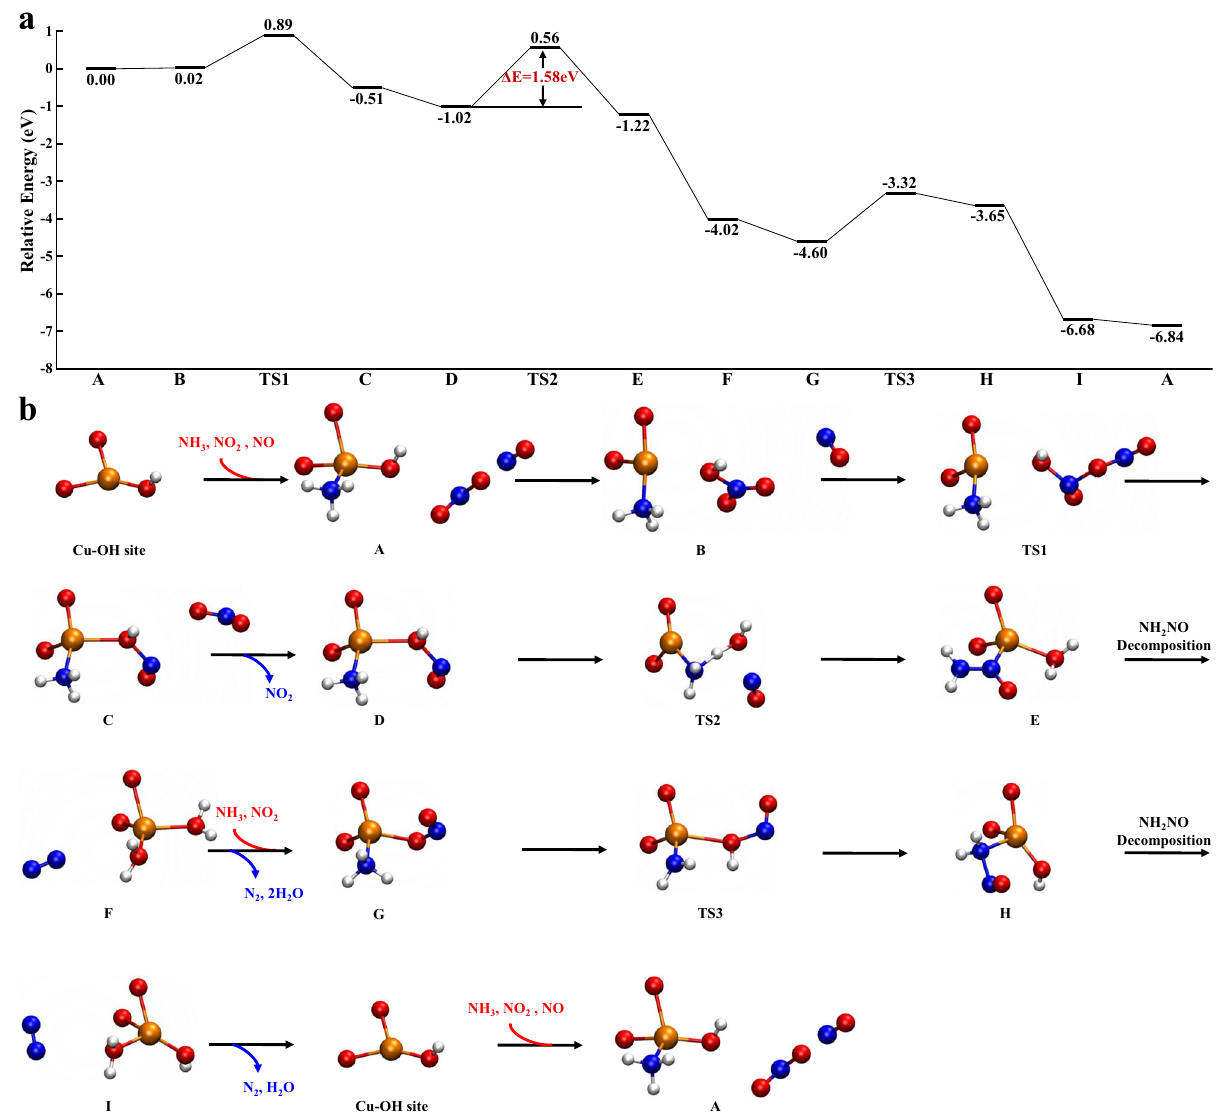
Fig. 5 | Reaction pathway of the fast SCR cycle at ZCu II OH site. a Gibbs free energy pro fi le. b Optimized geometries of the reactants, TSs and products for all elementary steps are presented in the lower panel. Except for the two O